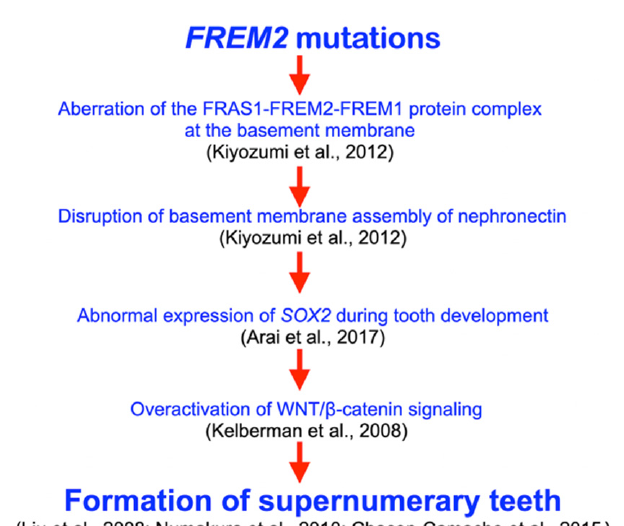
Figure 7. Hypothetical flowchart shows pathogenetic pathway as a result of FREM2 mutations. Heterozygous missense variants in FREM2 result in alterations of FRAS1-FREM2-FREM1 complex, disruption of basement membrane assembly of nephronectin, abnormal expression of SOX2 , overactivation of WNT/ β -catenin signaling, and subsequent formation of supernumerary teeth [26,29,33– 36].